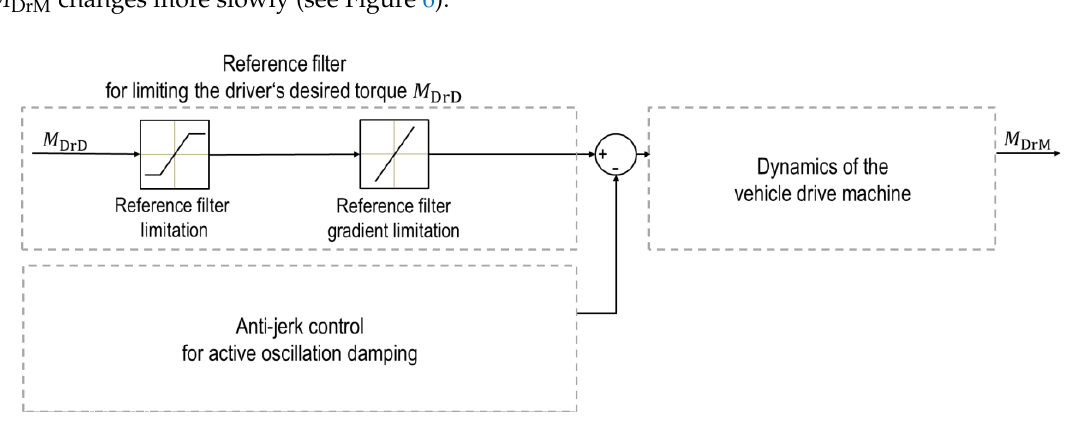
Table 1. Parameters and compared values of the measurements.